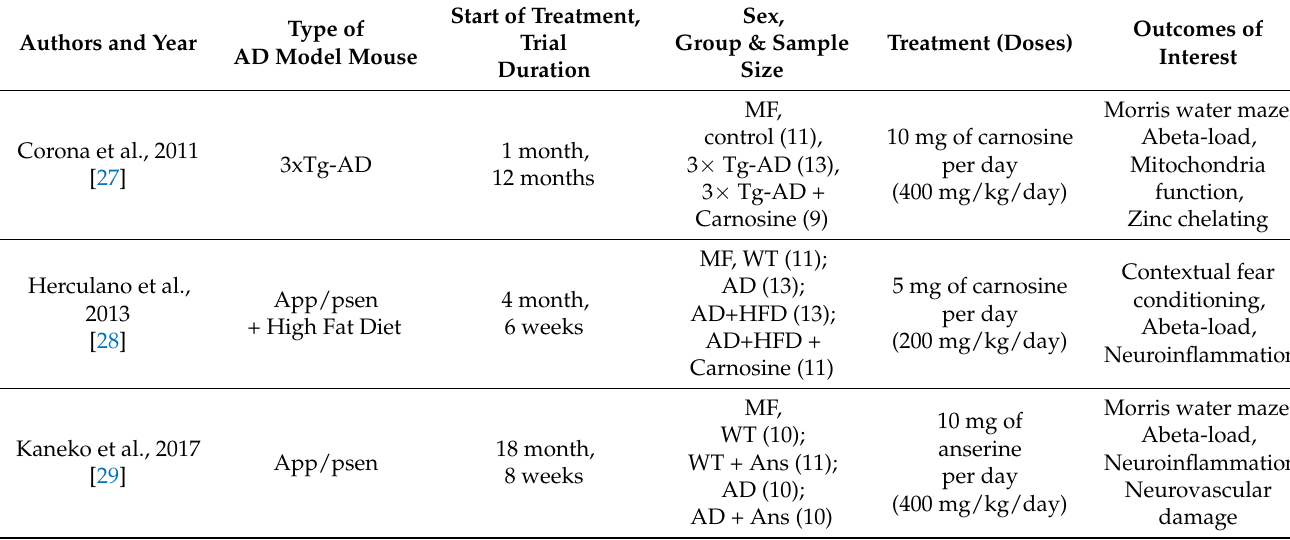
Table 1. Main characteristics of the imidazole dipeptide studies in Alzheimer’s disease (AD) model mouse.